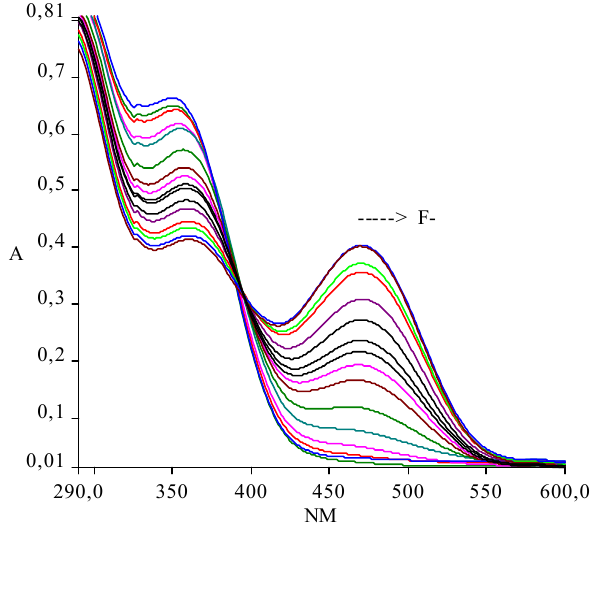
Figure 3. UV-Vis spectral titration of 5 × 10 − 5 mol L − 1 solution the title compound with a standard solution of F − (as tetrabutylammonium salt) in DMSO solution at 298.2 ± 0.1